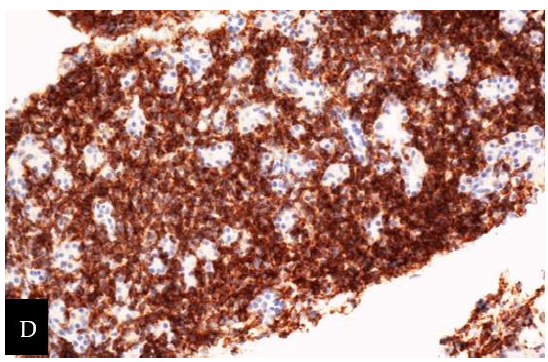
Figure 4. Pathologic findings. ( A ) Acinar cell structure is destroyed by diffusely infiltrated tumor cell (HE, ×100). ( B ) Irregular pleomorphic hyper-chromatin nuclei is observed (HE, ×400). ( C , D ) CD 3 and CD 56 is positive in immunohistochemical (IHC) stain. ( E ) CD 20 is negative in IHC stain.